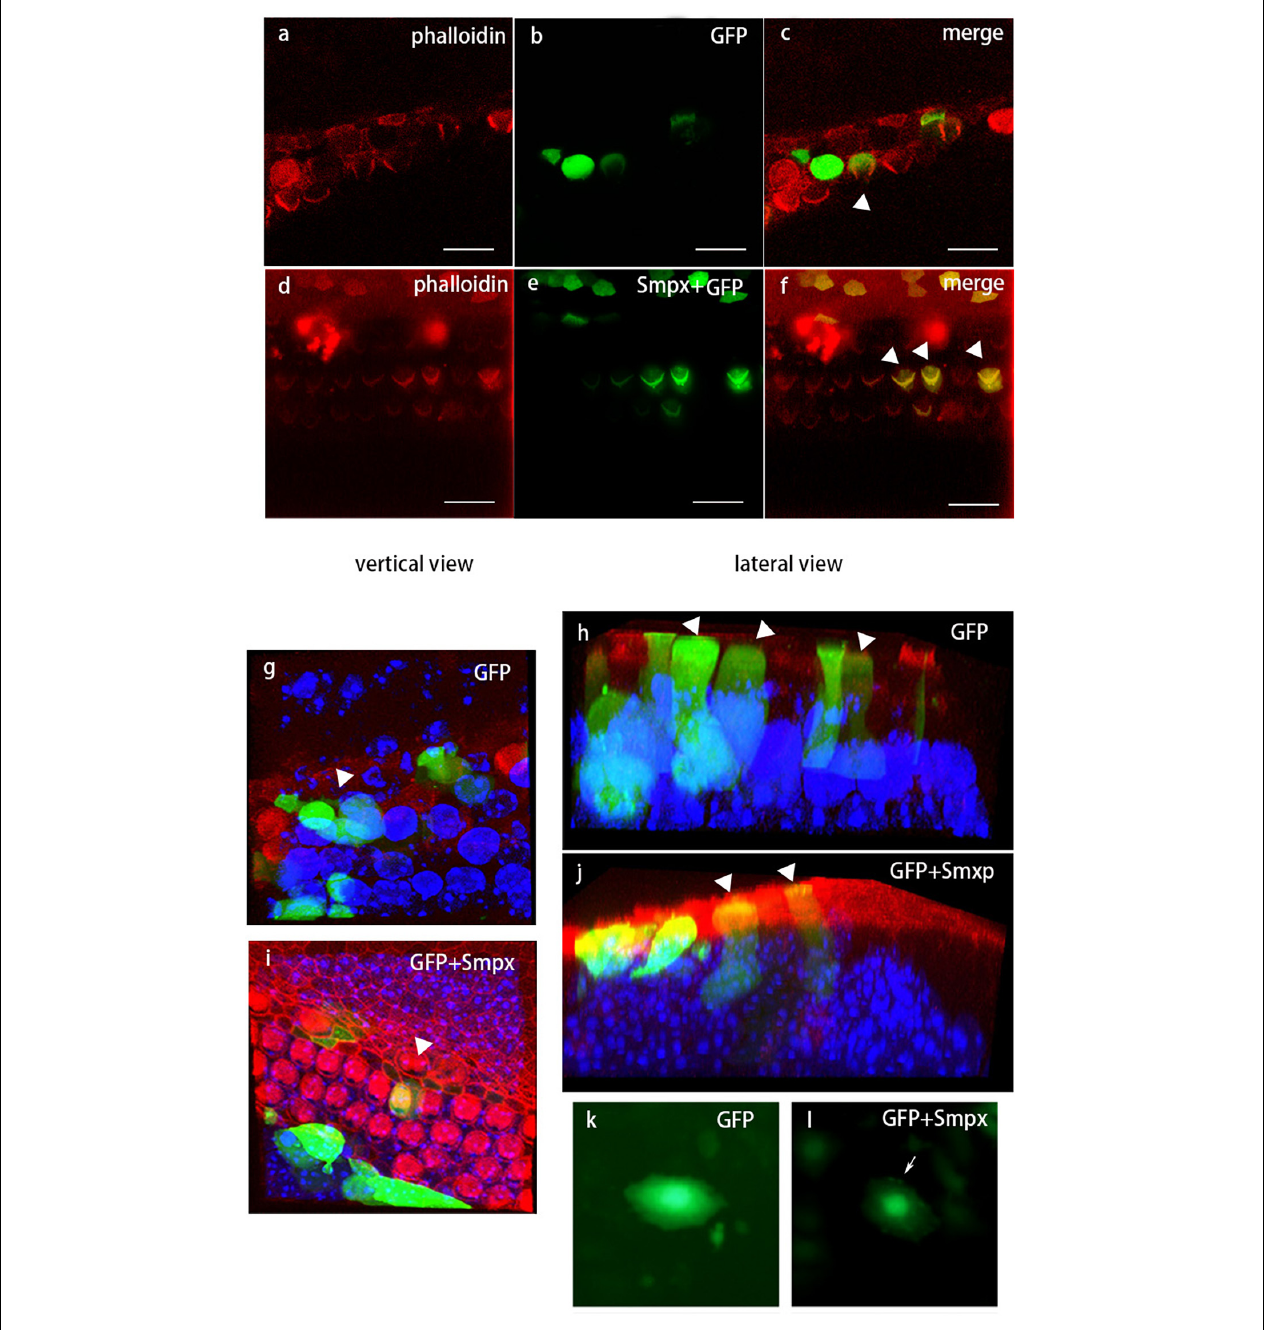
FIGURE 7 | Localization of Smpx in hair cells via in vivo electrotransfection (injectoporation). Red, phalloidin; Green, GFP. (a-c) Hair cells transfected with pEGFP. These images showed GFP was expressed in the cell body but not in the stereocilia. (d-f) Hair cells transfected with pEGFP-Smpx. The obvious “V” shape indicated that GFP-Smpx was located in stereocilia. (g-j) Three-dimensional image of transfected hair cells. Red, phalloidin; Green, GFP; blue, DAPI. 3D images displayed a clearer expression of GFP and GFP-Smpx. (k,l) Hela cells transfected with pEGFP and pEGFP-Smpx. The fusion protein GFP-Smpx should be tested before injectoporation to confirm if GFP would affect the localization of